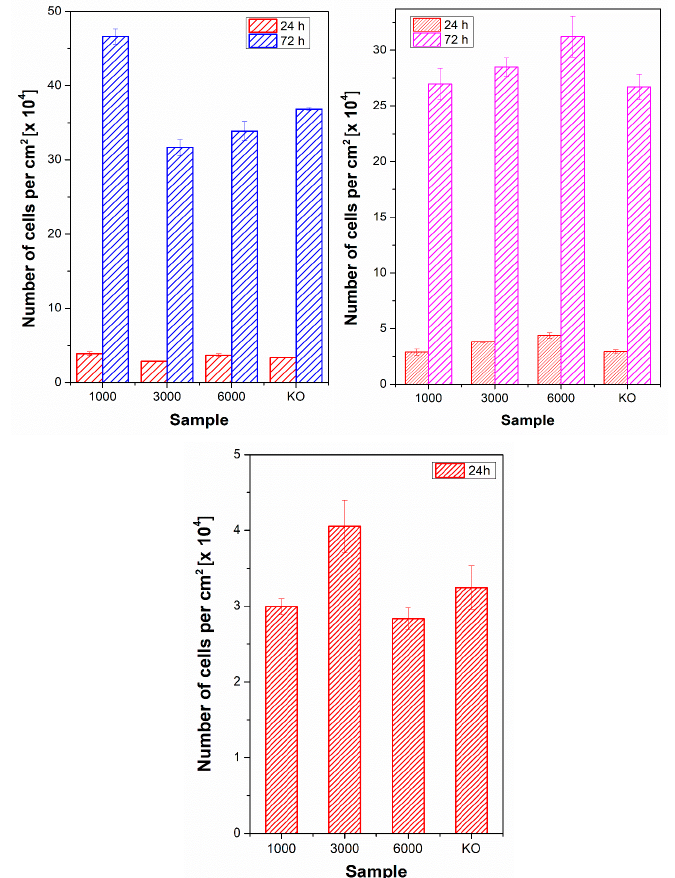
Figure 10. The number of adhered (24 h) and proliferated (72 h) U-2 OS cells on laser-treated polyethersulfone (PES, left image) and polystyrene (PS, right image) with the fluence of 10 mJ·cm − 2 and 1000, 3000, and 6000 pulses. Due to strong fluorescence, only results after 24 h are introduced for PEN substrate. Tissue culture polystyrene was used as a control (KO). We have also analyzed the SEM scans of U2-OS samples which were proliferated on the studied polymers treated with a different number of laser pulses (Figure 11). The SEM images clearly show the influence of the cell shape; the shape extension in the direction of the LIPSS pattern is most pronounced for polymers treated with 6000 pulses and PEN and PES polymers treated with 3000 pulses.